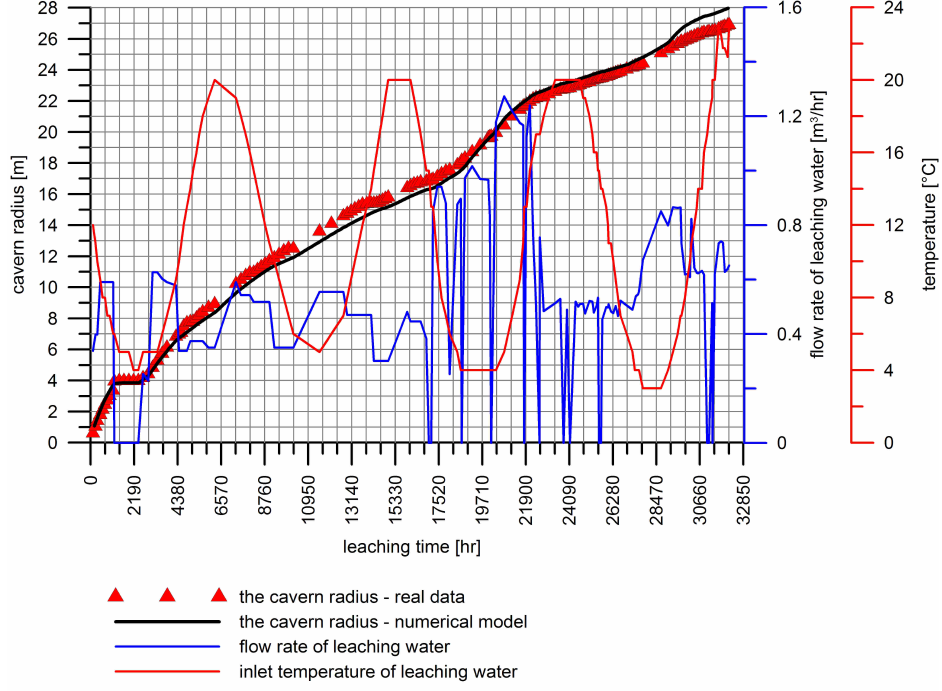
Figure 9. The comparison of the numerical modeling results with measured data concerning the changes of the Z2 cavern radius during the leaching